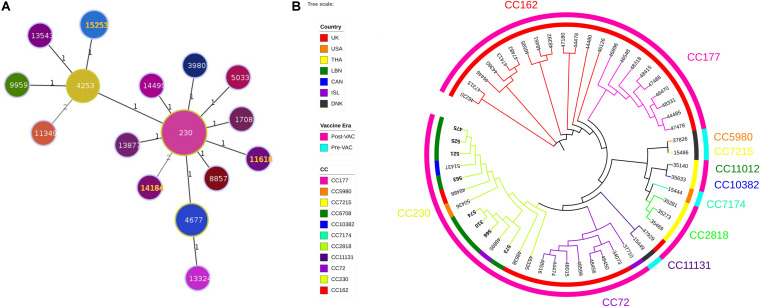
(A) Minimum Spanning Tree (MST) analysis of serogroup 24 isolates. PHYLOViZ full MST algorithm presenting clonal complexes (CCs) using sequence types (STs) belonging to serotype 24 deposited in the PubMLST database as of 20 June 2020. STs are represented by circles proportional in size to the number of isolates. STs highlighted in orange corresponds to the Lebanese study isolates. Branch labels are the number of allelic variations between STs (number 1 represents single locus variant while number 2 represents double locus variants). STs links are grayscaled where darker links have less differences than the lighter gray links. (B) Whole genome SNP-derived phylogenetic tree. SNP-based phylogeny of 54 genomes, including 8 from the present study and 46 publically available closed genomes from the PubMLST database. Colored numbers presented on the outer most perimeter represents the MLST clonal complex of the isolates starting from its corresponding branches. Inner circle indicates the geographic origin of each strain: red: United Kingdom, orange: United States of America, yellow: Thailand, green: Lebanon, dark blue: Canada: purple: Iceland and black: Denmark. Outer circle is the study periods where cyan and fuchsia represent the pre- and post-vaccination periods, respectively. The leaf labels indicate the PubMLST isolates ID of the selected S. pneumoniae isolates.